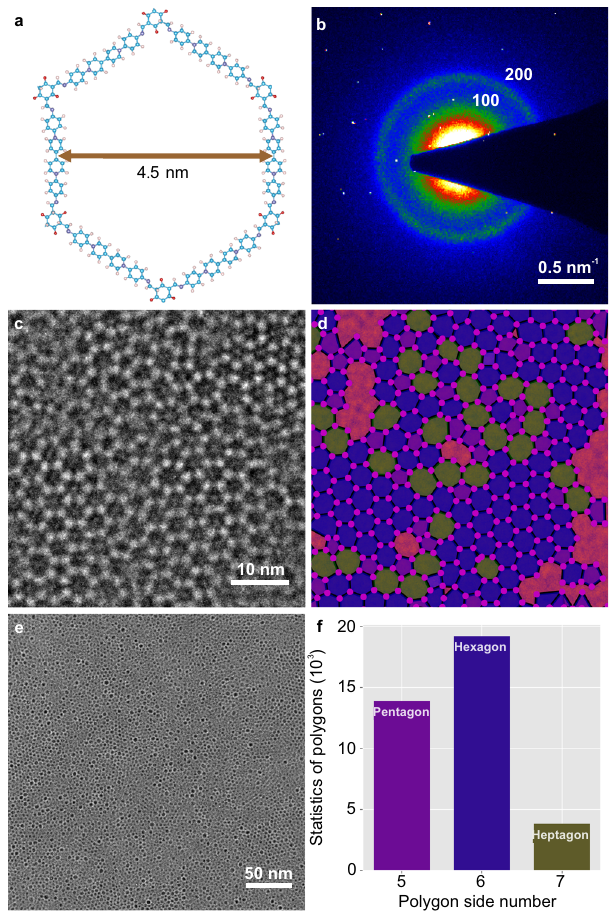
Fig. 5 TEM characterization and statistical structural analysis of a -PI. a Atomic structure of the a -PI, the pore diameter is 4.5 nm. b SAED pattern of a -PI showing faint diffraction rings only up to the second order. c AC- HRTEM image of a -PI showing the lack of long-range order. The bright spots correspond to the node molecules. Scale bar: 10 nm. d Neural network polygon mapping of ( c ). The pink spots mark the node molecule positions, and the polygons are colored according to their number of sides (pentagon: purple; hexagon: blue; heptagon: green). e Overview TEM image demonstrating the presence of different polygon types on a larger scale. Scale bar: 50 nm. f Statistical results of the polygon distribution from a data set of nine AC-HRTEM images, each having a fi eld-of-view of 200 nm 2